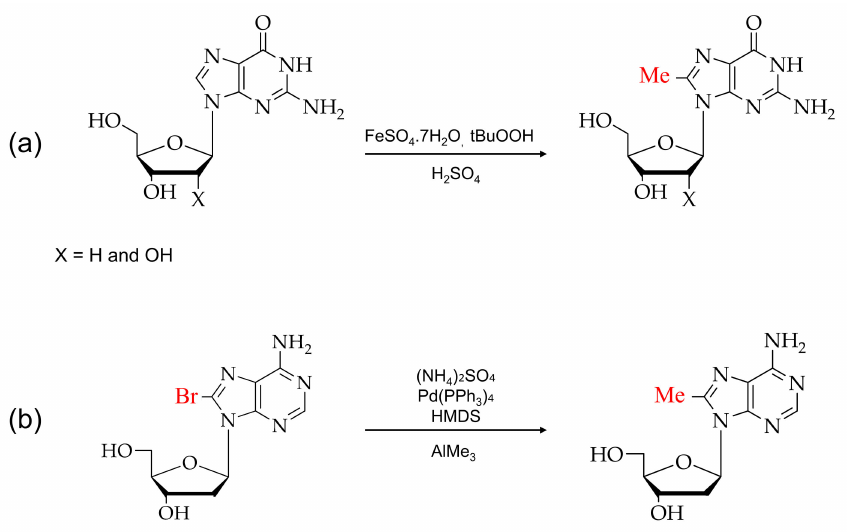
Figure 2. Methylations of purines: ( a ) 8-methylguanosines and ( b ) 8-methyladenosines. Bromide and methyl groups are